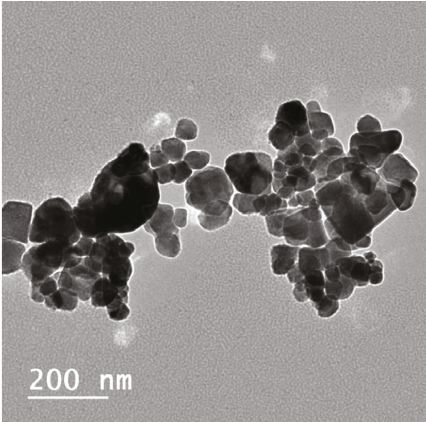
Figure 20: TEM image of Cr